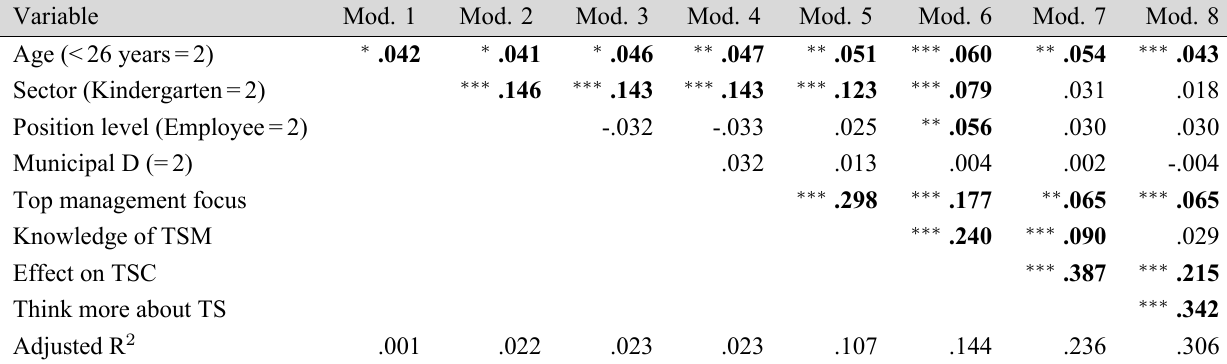
Table 7 Linear regression. Dependent variable: ‘The fact that we have been approved as a Traffic Safe Municipality has led to: “I behave more safely when I travel in traffic during working hours, whether I am a pedestrian, cyclist or car driver.” ’ Standardized beta